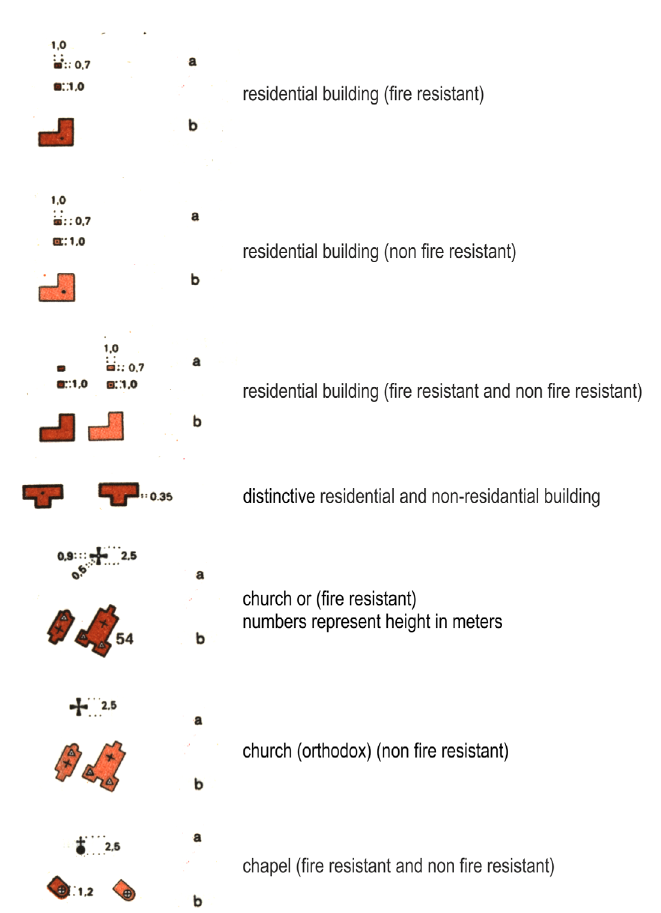
Fig. 1. A part of instructions for development of a military map at the scale of 1:10,000: a – symbols of ob - jects that cannot be represented on the map’s scale, b – symbols of objects that can be depicted in this